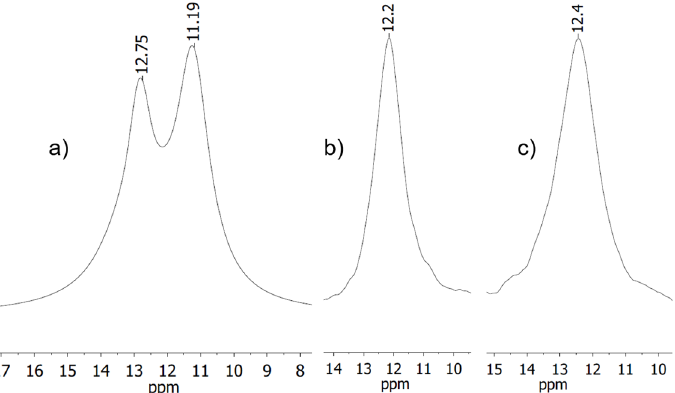
Figure 1. Sections of the 31 P{ 1 H} NMR spectra measured in CD 2 Cl 2 for reactions carried out in ( a ) DCM; ( b ) MeCN; ( c )